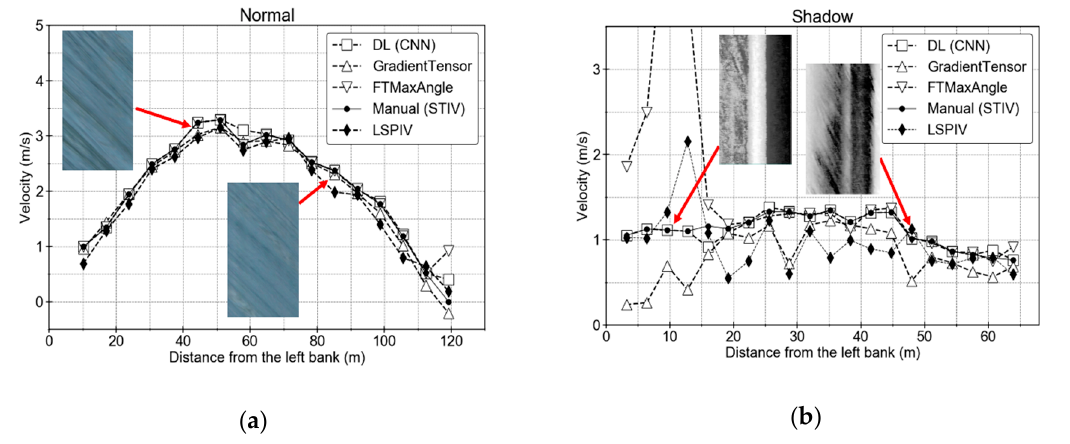
Figure 14. Comparison of cross-sectional flow velocity distributions: ( a ) normal case; ( b ) shadow case (STIs on the graph are histogram equalization filtered for visibility).